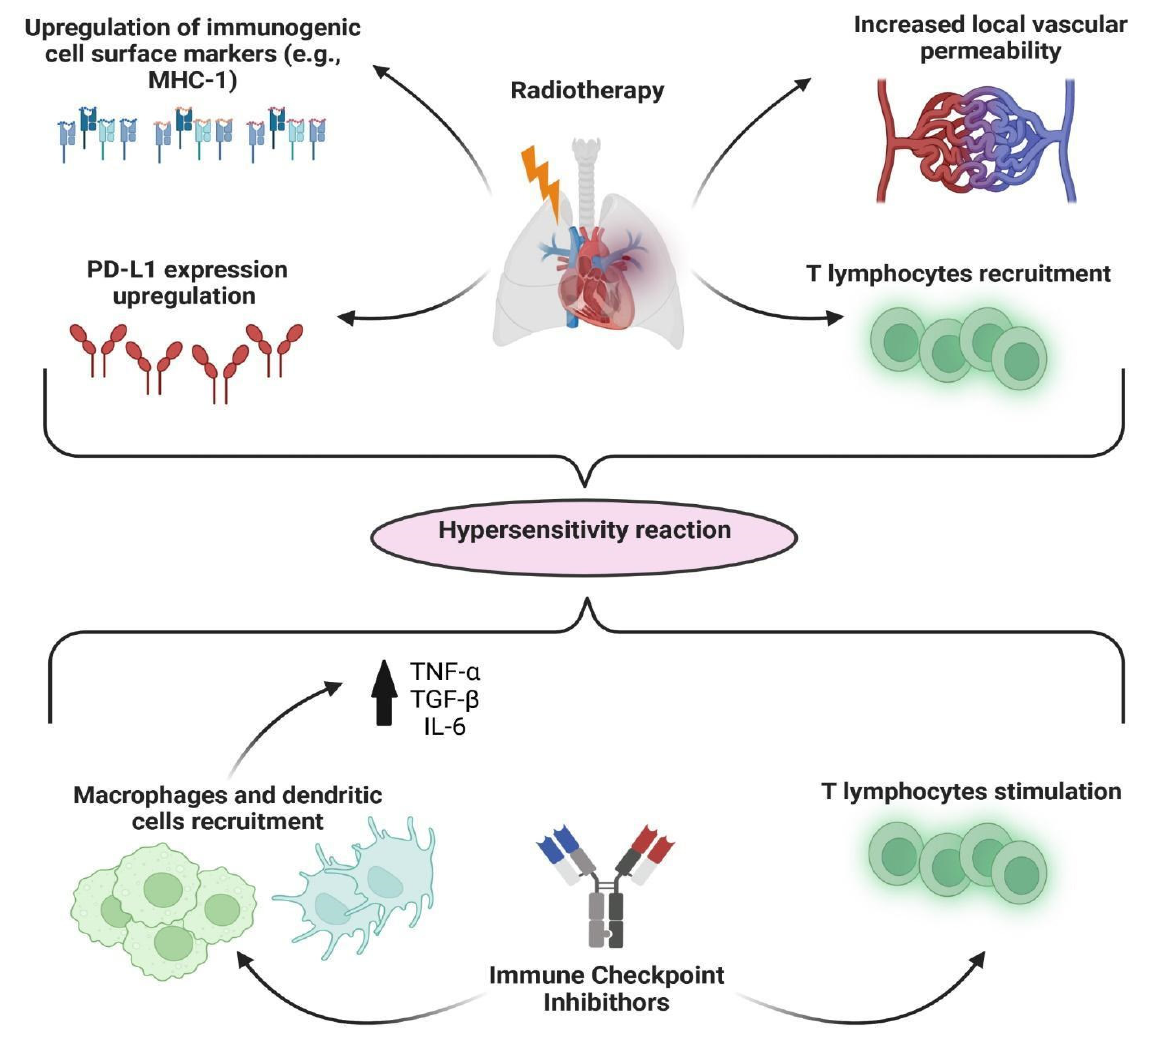
Figure 2. Possible mechanisms for inducing RRP. RT promotes a latent pro-inflammatory state through: (i) expression up-regulation of immunogenic cell surface markers (e.g., MHC-1), making the tumor cells more susceptible to CD8+ T-cell recognition and destruction; (ii) increased T-cell recruitment, lowering the inflammatory response threshold; (iii) PD-L1 expression up-regulation, leading to irradiated lung tissue hypersensitivity and anti-PD-1 blockade overreaction; (iv) increased local vascular permeability and proliferative changes. ICIs stimulate exhausted tumor-infiltrating lymphocytes and recruit new ones, leading to the recruitment of innate immunity cells (macrophages and dendritic cells) and increased production of inflammatory cytokines (TNF, IL-6, TGF β , IL-4), evoking a hypersensitivity reaction in such a pre-sensitized tissue. MHC-1 = major histocompatibility complex type 1; PDL-1 = programmed cell death ligand-1; TNF- α / β = tumor necrosis factor; IL-6 = interleukin-6.